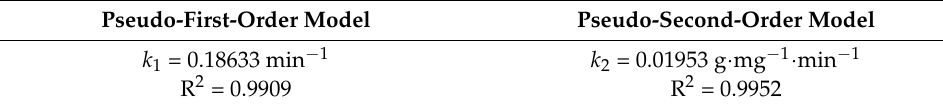
Table 1. Comparison of the pseudo-first and pseudo-second-order constants.